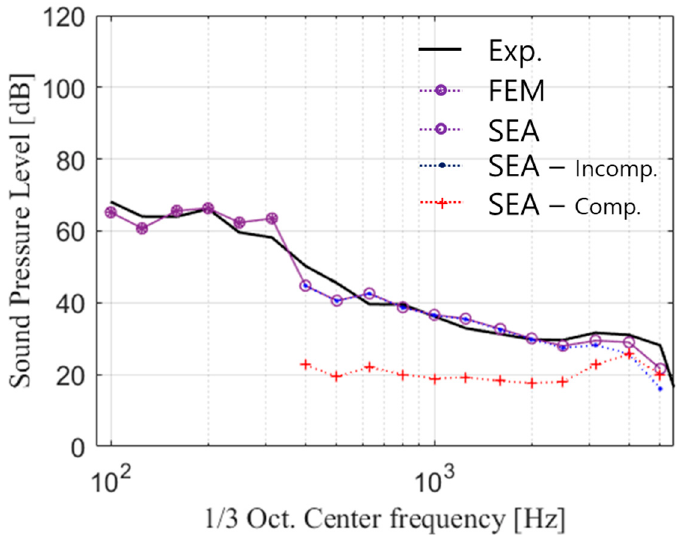
Figure 24. Comparison of numerical and measured interior noise levels using the injected power formula of Equation (75).